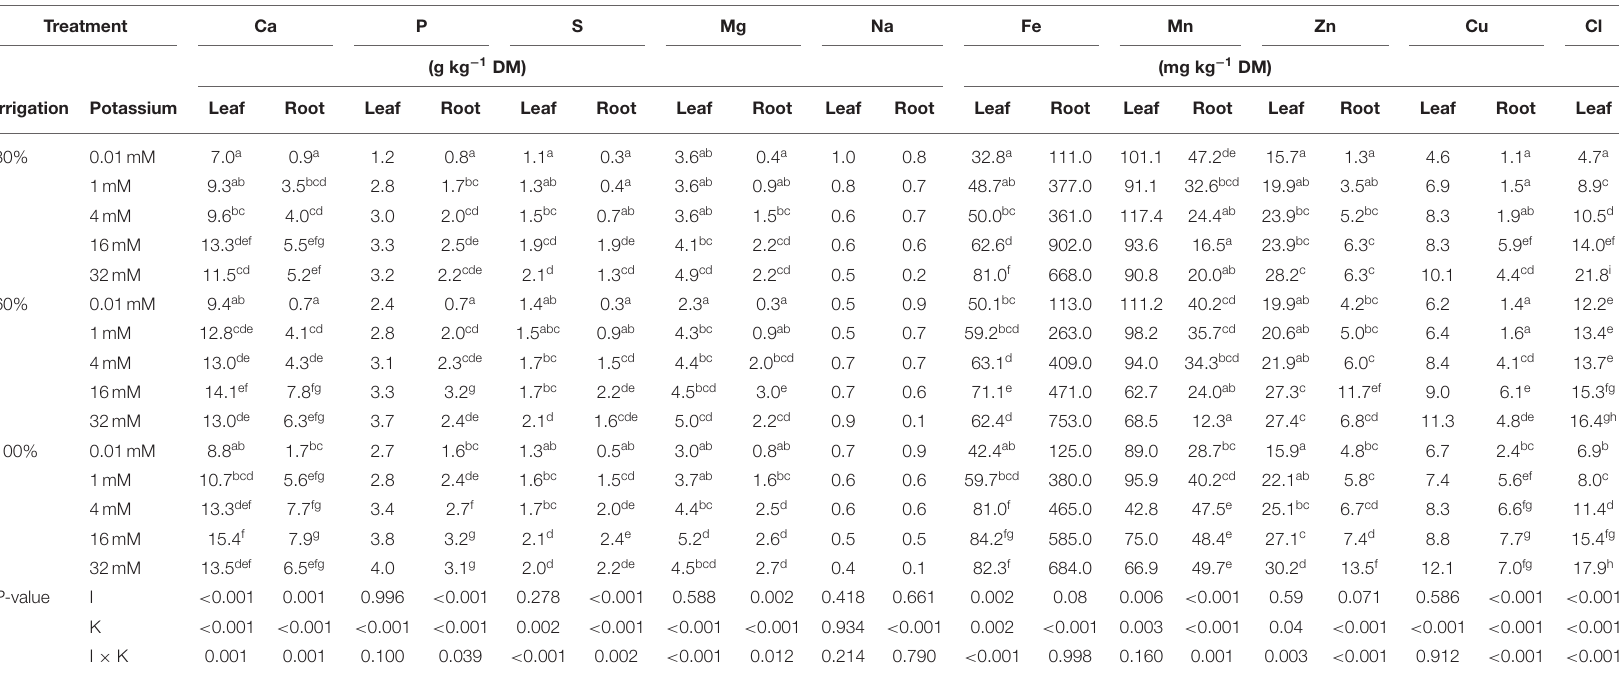
TABLE 2 | Mineral content of young cassava plants in response to deficit irrigation and potassium fertigation.